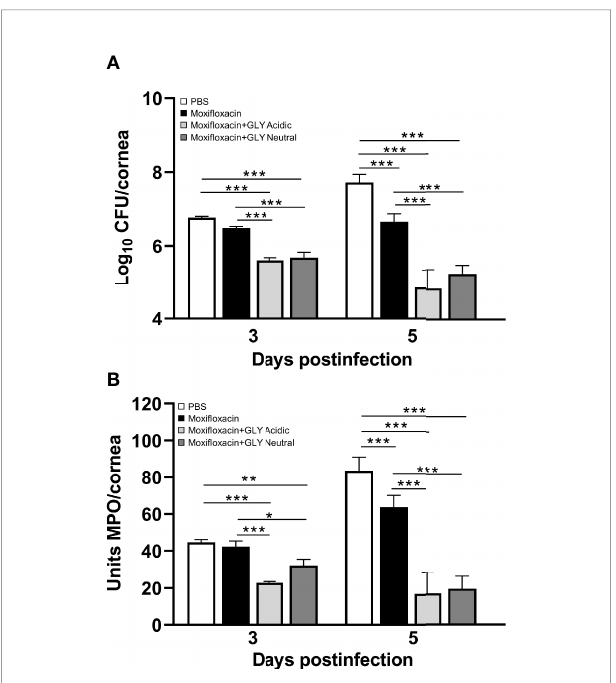
FIGURE 8 | Effects of GLY pH on corneas infected with MDR9. (A) Bacterial plate counts and (B) MPO levels at 3 and 5 days p.i. after treatment with moxi fl oxacin plus acidic or neutral GLY vs . PBS or moxi fl oxacin alone were signi fi cantly reduced. Data are expressed as mean ± SEM (*p < 0.05, **p < 0.01, ***p < 0.001, n =